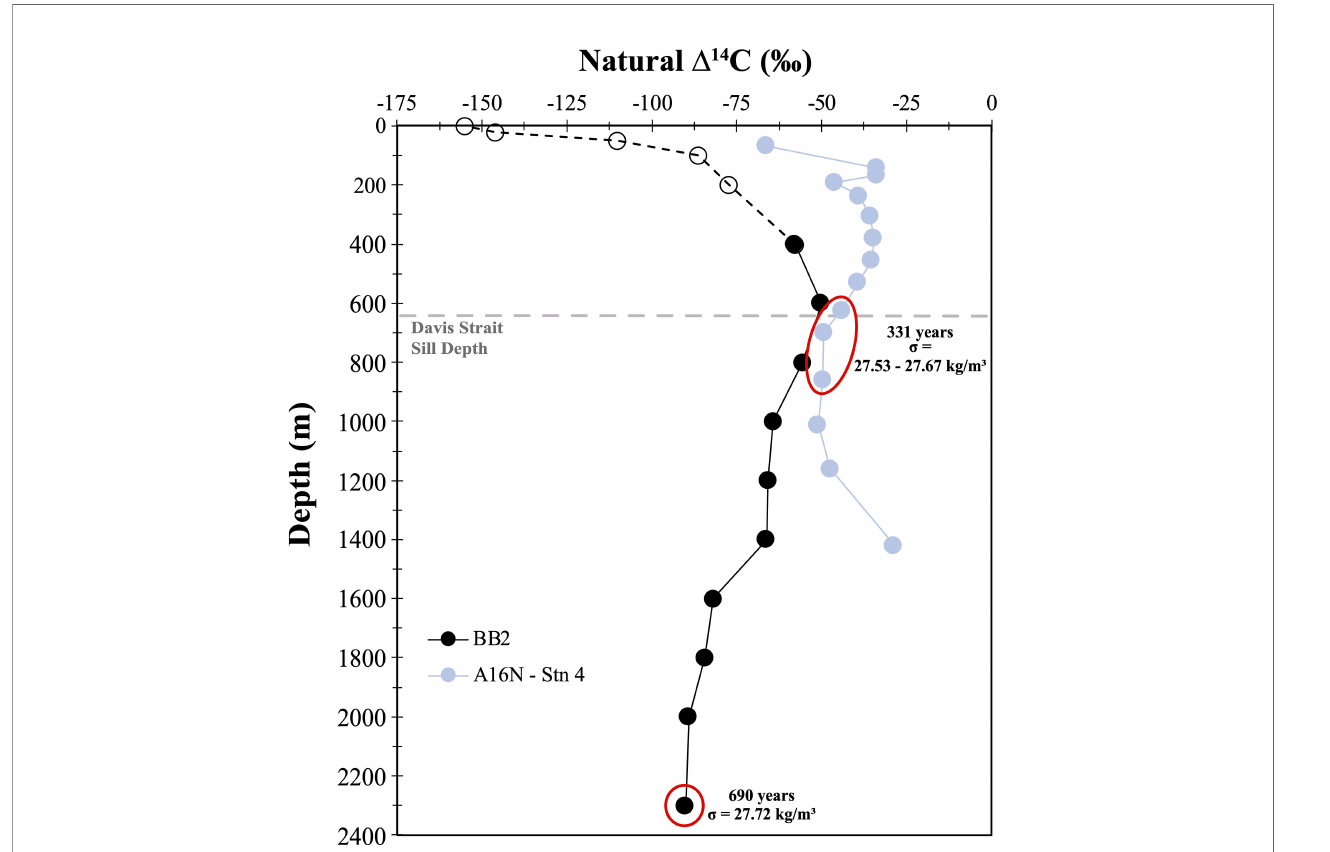
FIGURE 6 | DIC D 14 C natural depth pro fi les, corrected for both D 14 C bomb and DIC anth contributions for Station BB2 and A16N. DIC D 14 C natural values from A16N (Station 4; 62.75°N, -20.00°W just south of Iceland) were corrected for DIC anth and D 14 C bomb . Apparent 14 C-ages are calculated based on D 14 C natural values ( see Natural Abundance Radiocarbon ( D 14 C) Analysis ) for depths with potential densities close to BBBW values ( q s = 27.7 kg m -3 ). Dashed horizontal grey line indicates depth of the Davis Strait sill, at 640m. Dashed line with open circles for BB2 pro fi le indicate unconstrained D 14 C natural values based on limitation of the P alk proxy. Red circles indicate depths at which apparent 14 C - ages were